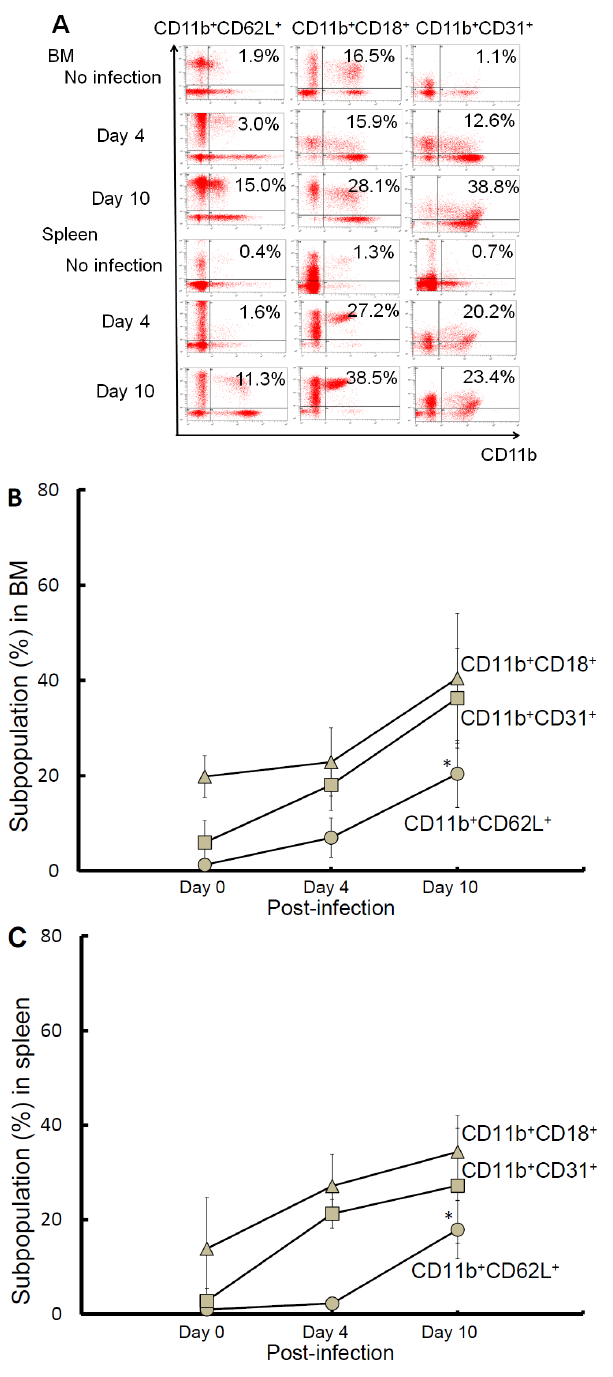
Figure 6. Changes in CD11b + selectin- and integrin-expressing cells during melioidosis. At the indicated times, splenic or BM cells were isolated and stained with fluorescence-conjugated anti-CD11b and CD62L (or CD18 or CD31) antibodies. As a representative sample, the proportion of CD11b + selectin (CD62L))- or integrin (CD18 or CD31)- expressing cells is shown (A). The average changes in the CD11b + CD62L + (gray circle), CD11b + CD18 + (gray triangle) and CD11b + CD31 + (gray square) populations (independent mice, n=3; independent duplicate experiments) are shown for BM (B) and spleen (C). The (*) symbol indicates p , 0.05 (day 4 vs. day 10).